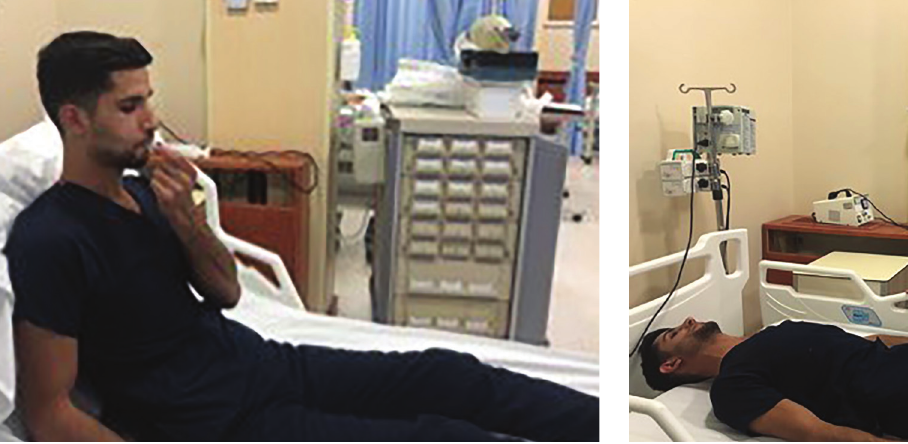
Figure 1. Modified Valsalva maneuver is performed by applying a 45 degree height to the patient's feet immediately after the standard Valsalva maneuver is